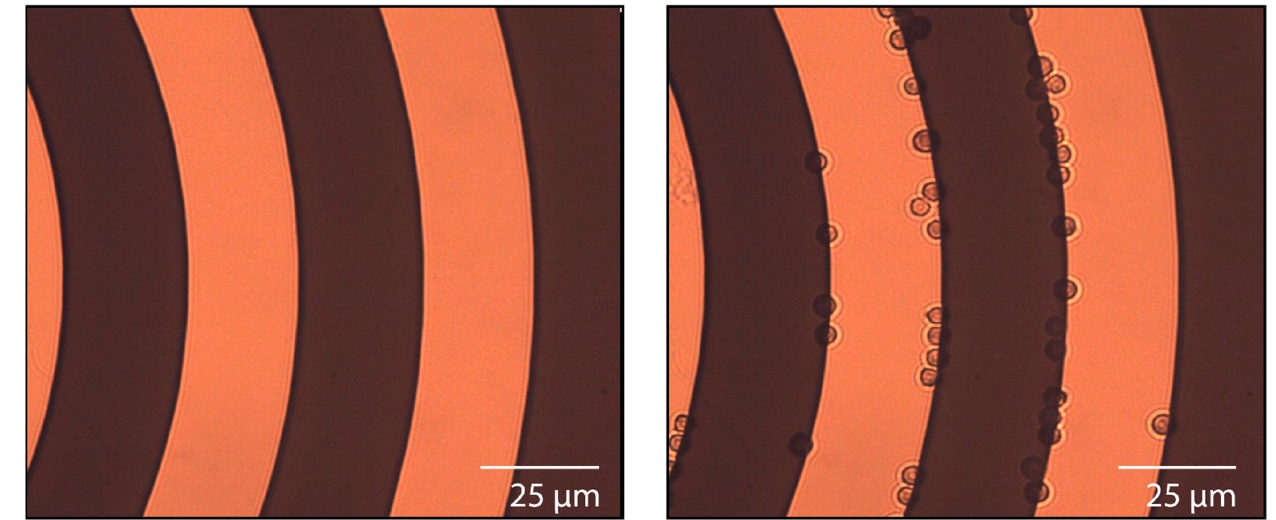
Figure 4. Bright field images show a section of the Fluid-Screen Chip’s circular ring-shaped electrode structure. Electric field off (left panel), electric field on (right panel). The cells are captured from deionized water spiked with Aspergillus brasiliensis suspension. When the electric field is off (left panel), there is no bacterial capture observed and Aspergillus brasiliensis (large size dark spheres) are suspended in the solution, which appears out of focus. After the electric field is applied, (right panel), Aspergillus brasiliensis cells come into focus and are visibly captured on the electrode edges and are held in place, in the focal plane of the microscope.